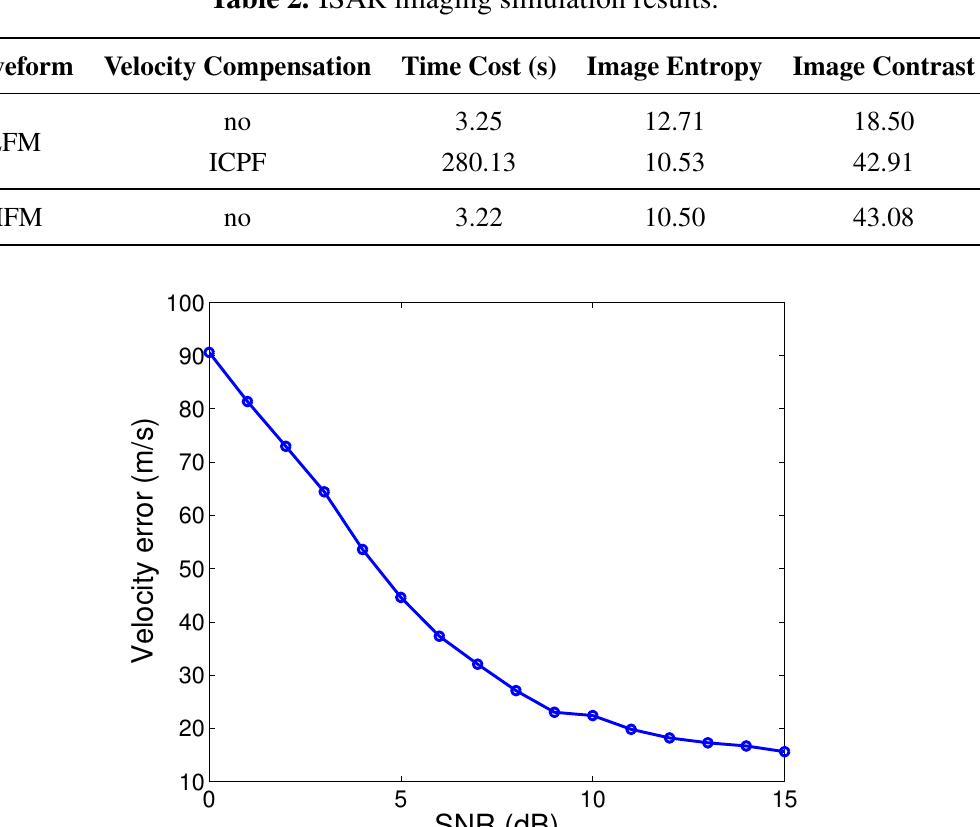
Table 2. ISAR imaging simulation results.